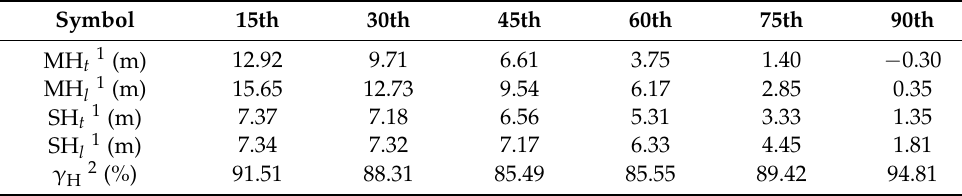
Table 1. The means and the standard deviations of HP t and HP l and the proportions γ H .